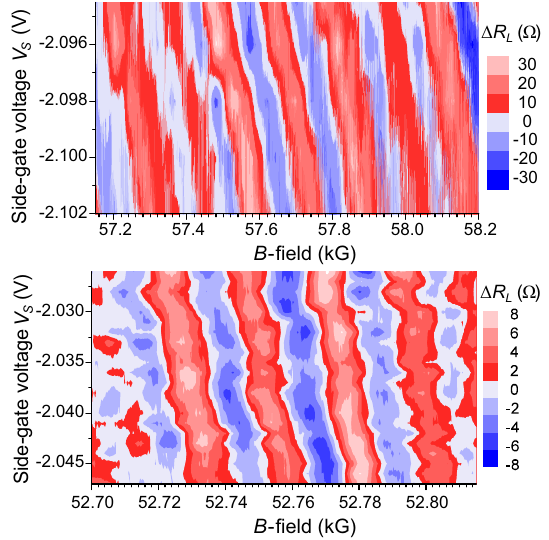
FIG. 5. Pajama plots showing the resistance oscillations at ν ¼ 3 (top) and ν ¼ 16 = 5 (bottom) as a function of both magnetic field B and side-gate voltage V consistent with the Aharonov- s Bohm as opposed to Coulomb-dominated nature of observed oscillations (top panel shows sample 6, preparation 3, device b; bottom panel shows sample 6, preparation 25, device b, for which the integer oscillations are shown in Fig. 4). Note that the integer period (top panel, preparation 3) indicates an active interferom- eter area roughly half that of the device used in bottom panel (preparation 25), yet still demonstrating a negative phase slope indicative of the AB